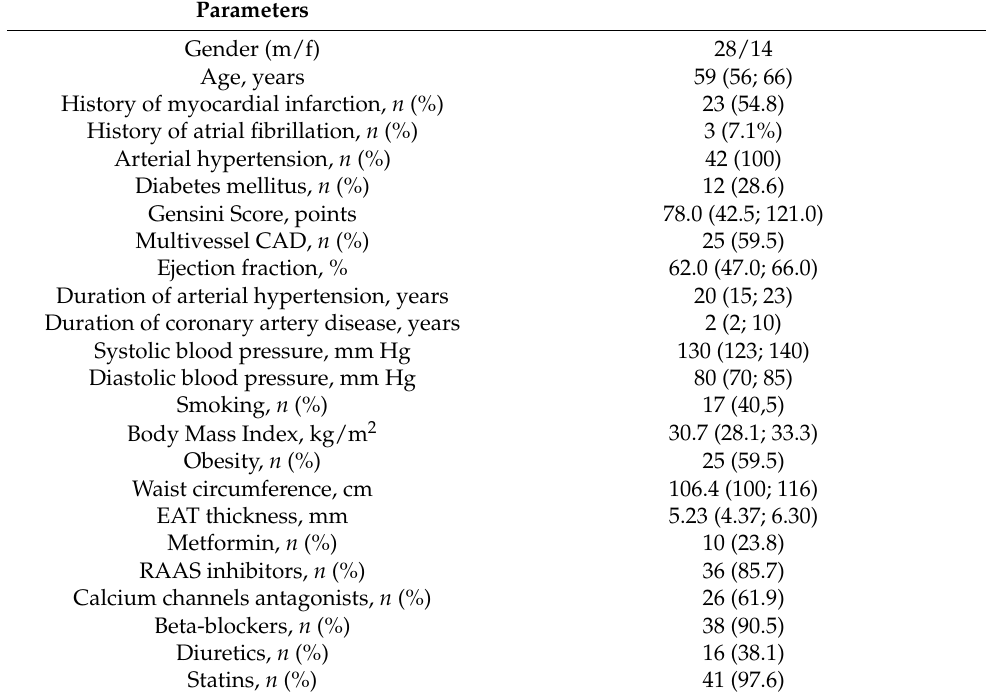
Table 1. Baseline characteristics of